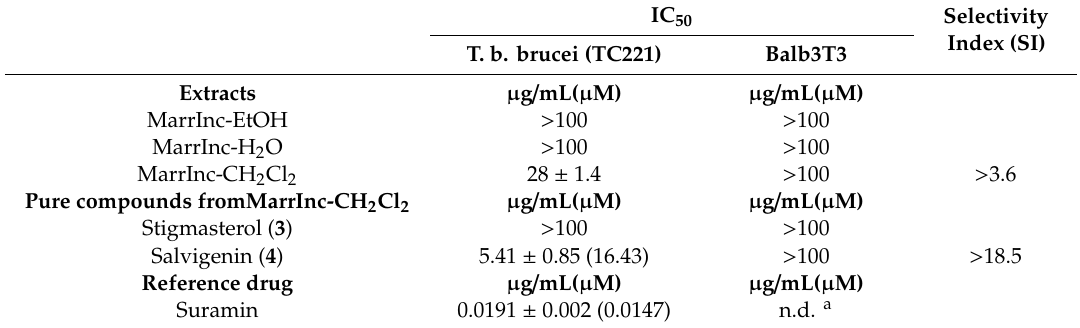
Table 2. Antitrypanosomal activity of Marrubium incanum (MarrInc) extracts and pure compounds.